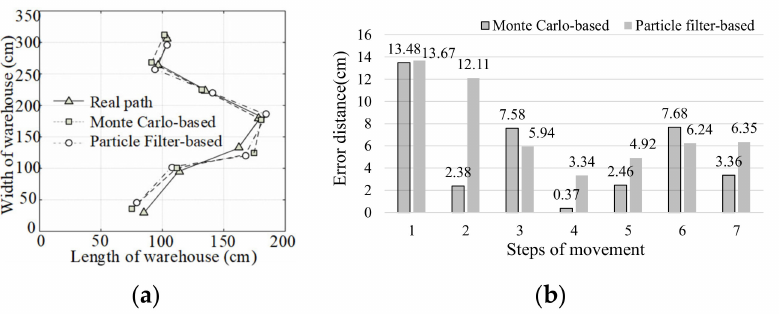
Figure 7. Simulation-based positioning results ( a ) and positioning errors ( b ) when the dual-antenna RFID system has two separated footprints.